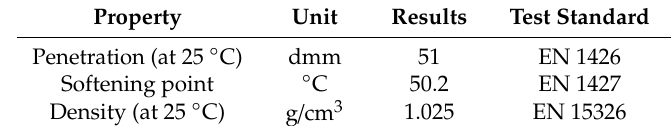
Table 1. Rheological properties of the reference bitumen.